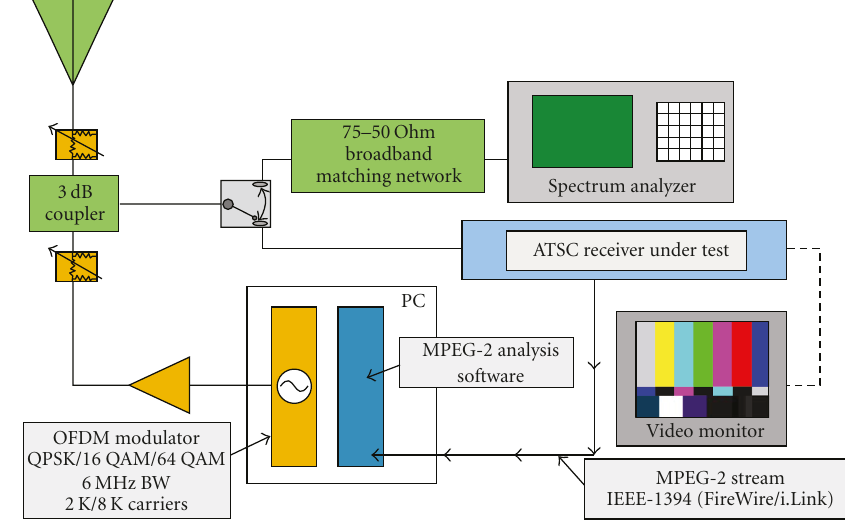
Figure 2: KU White Space Device Emulator and Testbed